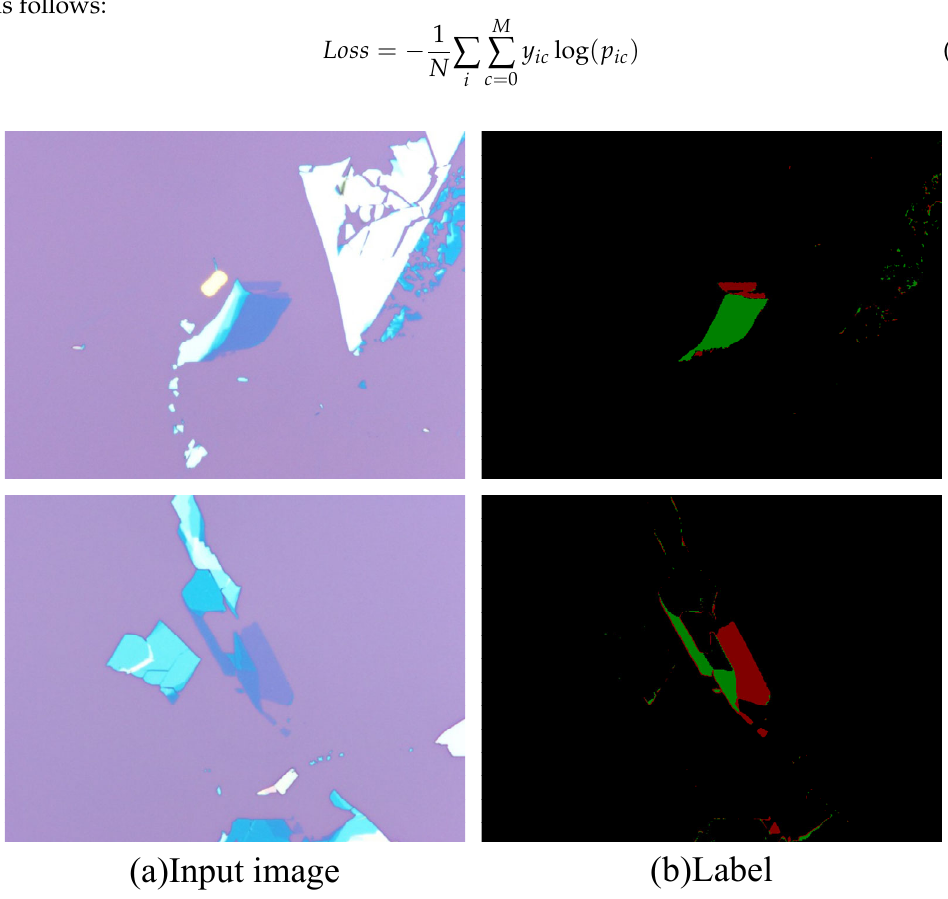
Figure 6. Experimental image [66]. ( a ) original image; ( b ) label image (Single layer marker in red, double layer marker in green, background marker in black.).